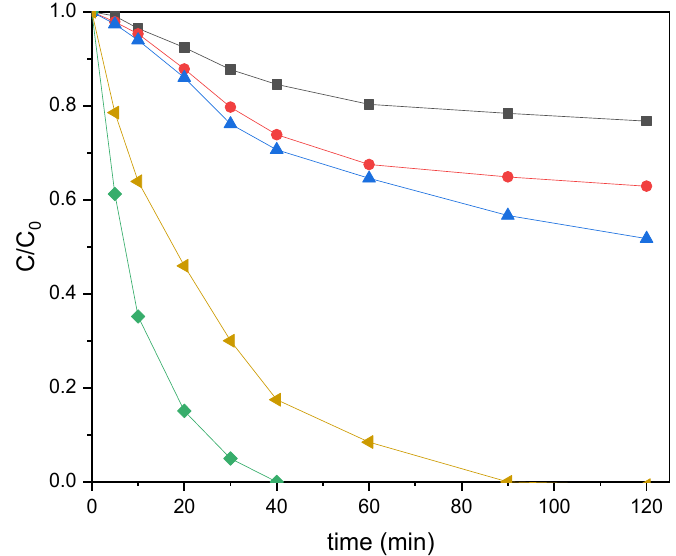
Figure 4. Degradation profiles with 0.26 mM (black line), 0.53 mM (red line) and 0.81 mM (blue line) Fe-DES concentrations for the Fenton treatment, and with 0.81 mMFe-DES concentration (yellow line) for the A-E-PMS treatment, which was also tested in homogeneous mode (0.81 mM, green line).